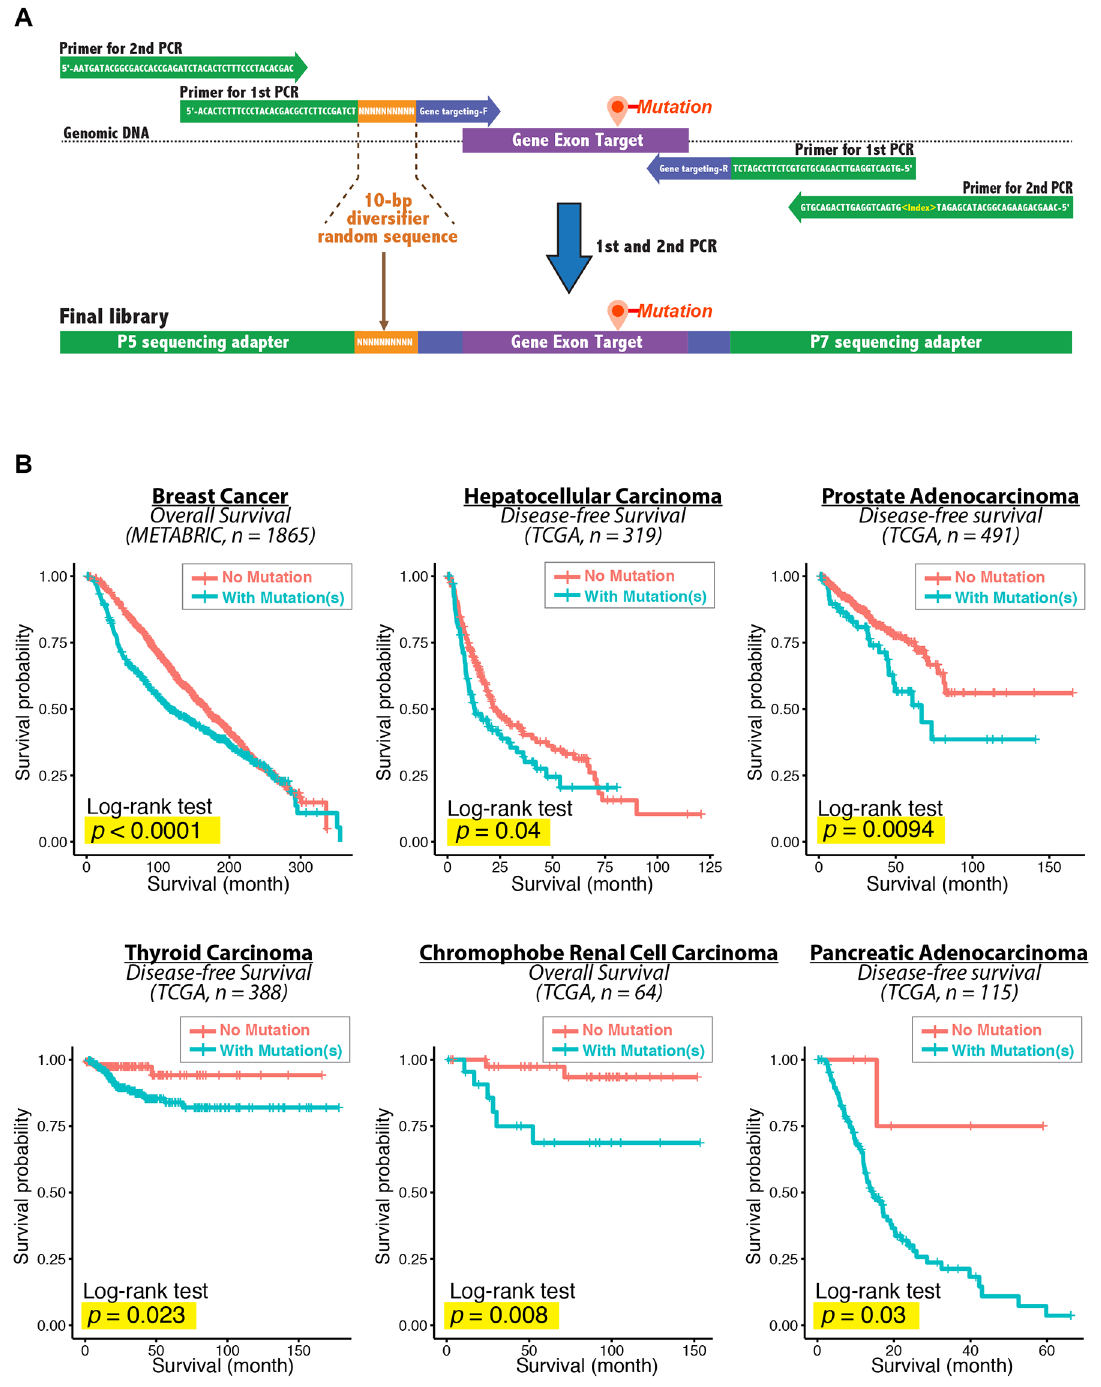
Fig 4. Schematic diagram of the 2-step library preparation. (A) Librarieswere preparedby two PCRs. The primer pair for the first PCR contains1) target-hybridizingsequences(blue), which bind to and amplify the exon targets; 2) a 10-bp diversifier sequencecomposedof random nucleotides (orange),which promotes accurate DNA cluster detectionduringsequencing runs; 3) a portion of P5 and P7 adapter sequences (green). The universalprimer pairs for the second PCR add a full P5 and P7 sequencing adapter (green)to the libraries.Primer sequencesare listed in S1 and S2 Tables. (B) Kaplan-Meier survival curves of cancer patients stratified by existence of mutations in their tumor tissues. Patients were groupedinto “No mutation” or “With mutation(s)” for analysis, accordingto their mutation status of NRAS , ESR1 , EGFR , KRAS , BRAF and TP53 genes. The log-ranktest p values comparing two survival curves are shown in each